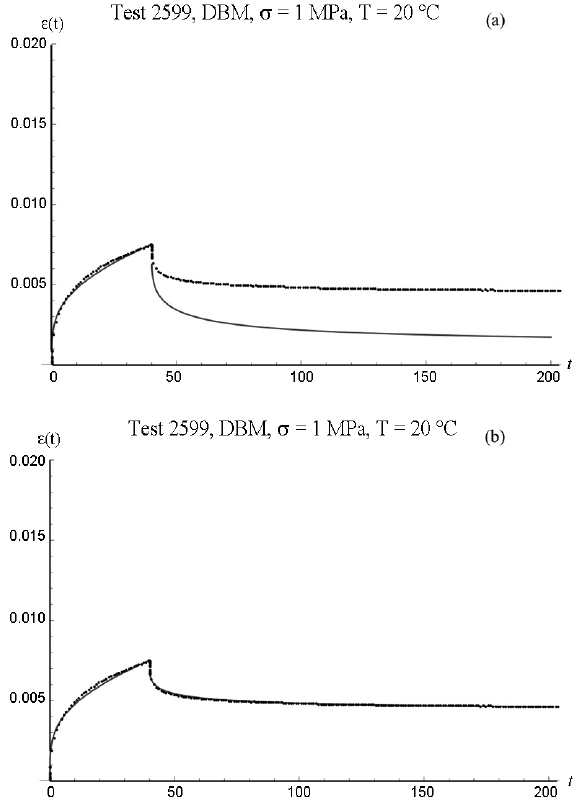
(c)Fig. 7. Creep Recovery test (2599): a) parameters evaluated by Eqn (11); b) parameters evaluated by Eqns (16, 18)